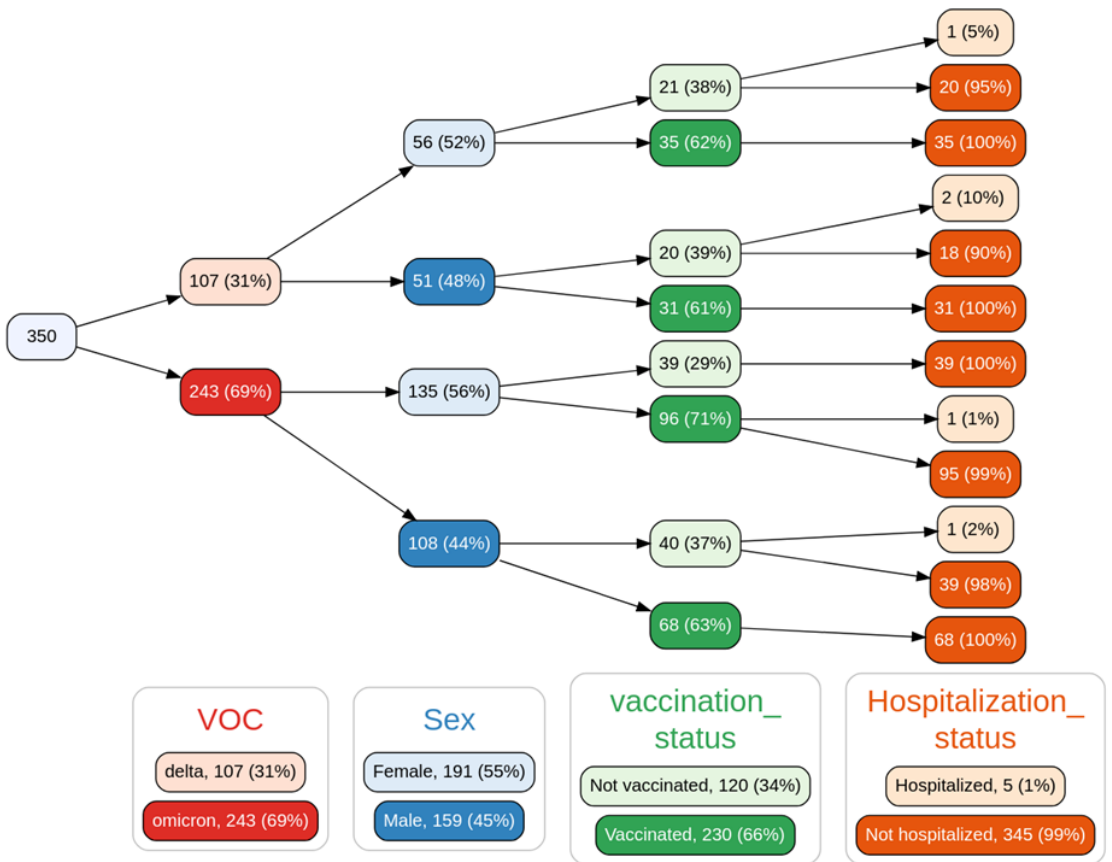
Figure 6. Variable tree with the spread of samples based on variant of concern (VOC), sex, vaccination status, and hospitalization status. Not shown: a single sample in the Delta->male->not vaccinated->hospitalized branch that was the only sequenced case from a patient who died in the analysis period. Only 350 of the 783 samples sequenced were able to provide the clinical data for this analysis. Table 1. p -values of the comparison ( Fisher’s exact test) between the Delta and Omicron variants.